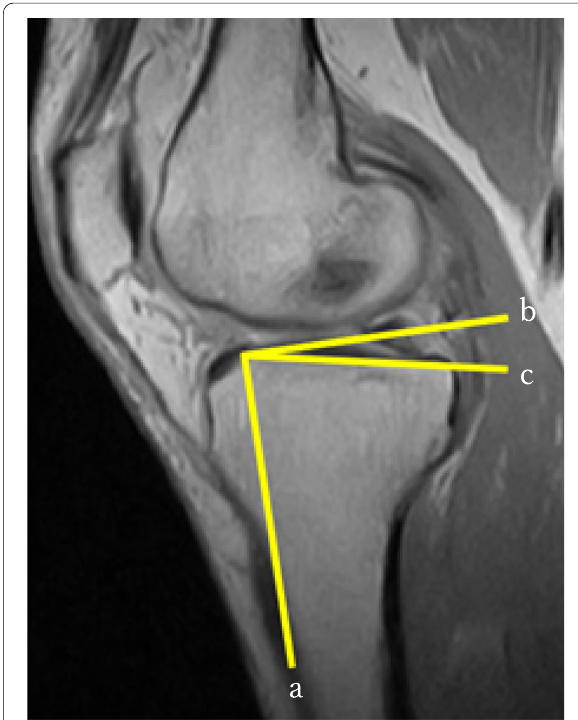
Fig. 5 Measurement of medial tibial posterior slope (MTPS). a : Parallel line of the diaphyseal tibial axis in the sagittal slice determined by an axial view of the tibial plateau; b : Perpendicular line to the line a from the anterior-most point of the tibial joint surface; c : Line connecting the posterior-most and anterior-most points; MTPS was determined as the angle between lines b and c